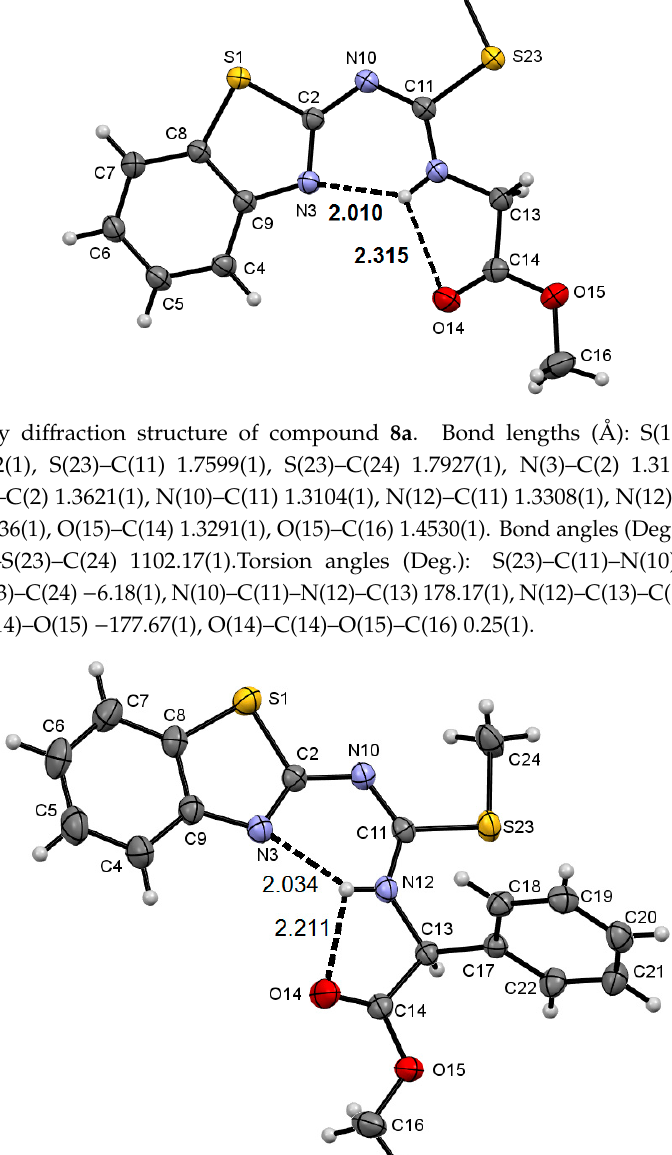
Figure 5. X-ray diffraction structure of compound 8b . Bond Lengths (Å): S(1)–C(2) 1.7618(1), S(1)–C(8) 1.7300(1), S(23)–C(11) 1.7667(1), S(23)–C(24) 1.7919(1), O(14)–C(14) 1.1870(1), O(15)–C(14) 1.3134(1), O(15)–C(16) 1.4522(1), N(3)–C(2) 1.2954(1), N(3)–C(9) 1.3912(1), N(10)–C(2) 1.3592(1), N(10)–C(11) 1.3043(1), N(12)–C(11) 1.3295(1), N(12)–C(13) 1.4527(1). Bond Angles (Deg.): C(2)–S(1)–C(8) 89.62(1), C(11)–S(23)–C(24) 101.25(1). Torsion angles (Deg.): N(3)–C(2)–S(1)–C(8) –0.35(1), N(10)–C(2)–S(1)– C(8) 179.59(1), S(1)–C(2)–N(3)–C(9) 0.18(1), N(10)–C(2)–N(3)–C(9) − 179.74(1), S(1)–C(2)–N(10)–C(11) − 177.17(1), N(3)–C(2)–N(10)–C(11) 2.75(1), N(10)–C(11)–S(23)–C(24) 5.19(1), N(12)–C(11)–S(23)–C(24) − 173.79(1), S(23)–C(11)–N(10)–C(2) 179.27(1), N(12)–C(11)–N(10)–C(2) − 1.88(1), S(23)–C(11)–N(12)– C(13) 0.16(1), N(10)–C(11)–N(12)–C(13) − 178.71(1), C(14)–C(13)–N(12)–C(11) − 85.82(1), C(17)–C(13)– N(12)–C(11) 147.32(1), C(17)–C(13)–C(14)–O(14) 140.21(1).